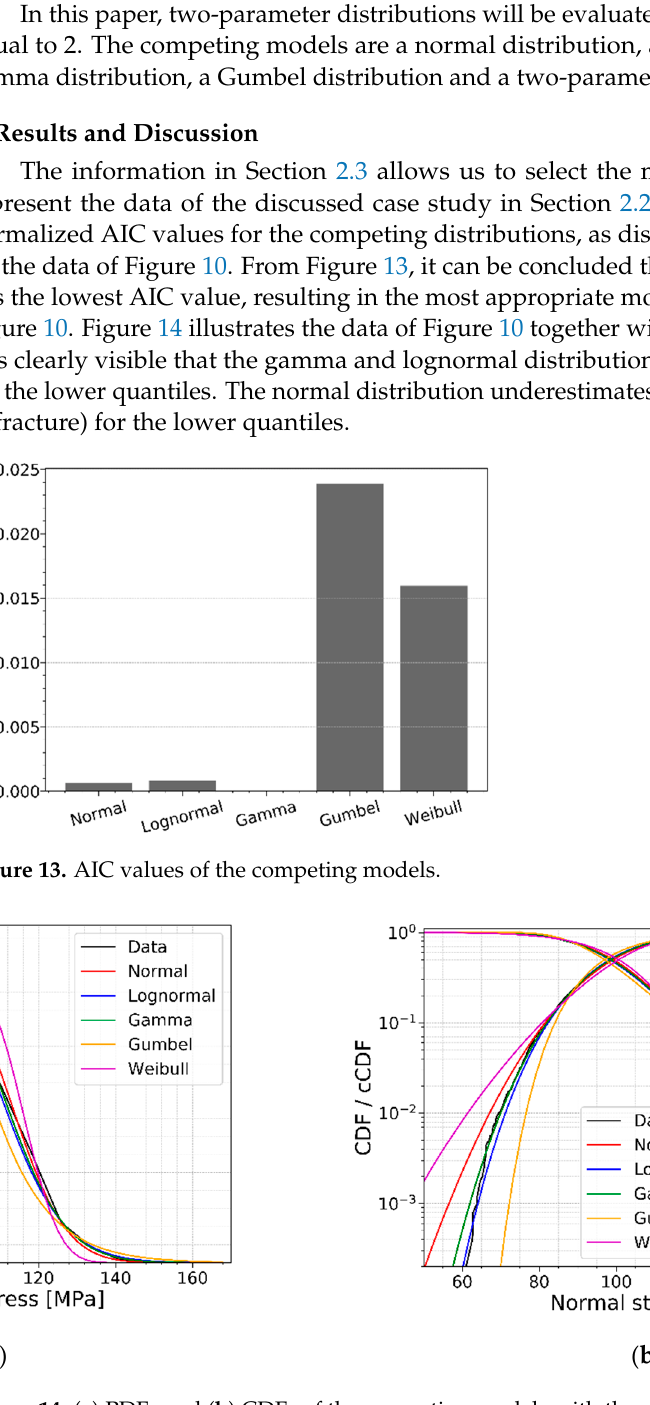
Figure 14. ( a ) PDFs and ( b ) CDFs of the competing models with the outcome data.